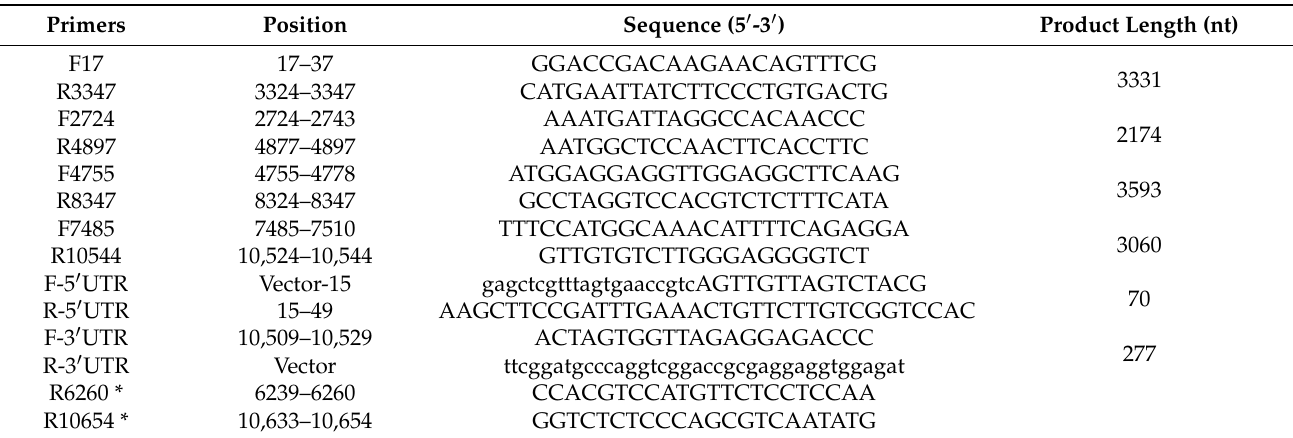
Table 1. Primers were used for RT-PCR of DENV-1 isolate,